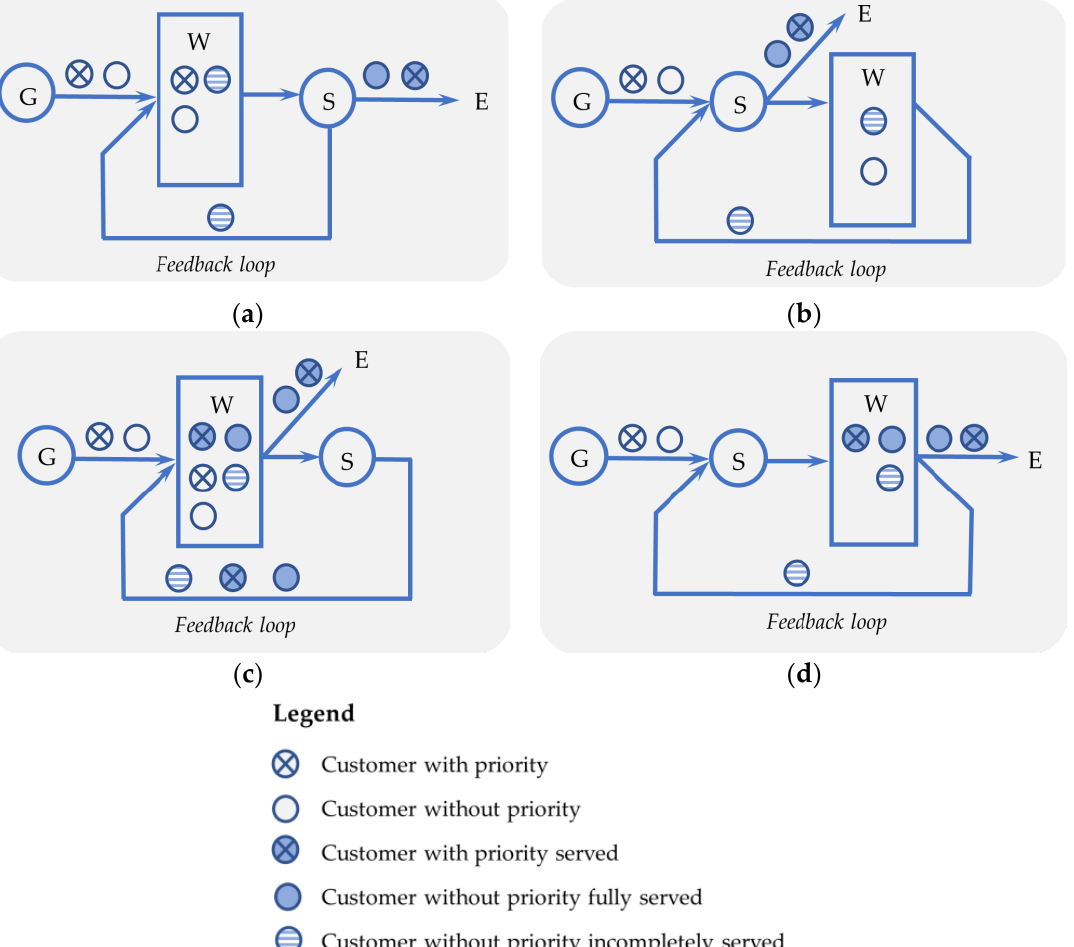
Figure 2. Relationships between the components in a system with interruptions: ( a , b ) Configurations for systems with interruptions and additional idle time; ( c , d ) Configurations for systems with interruptions and “storage” for departure according to the dispatching schedule.